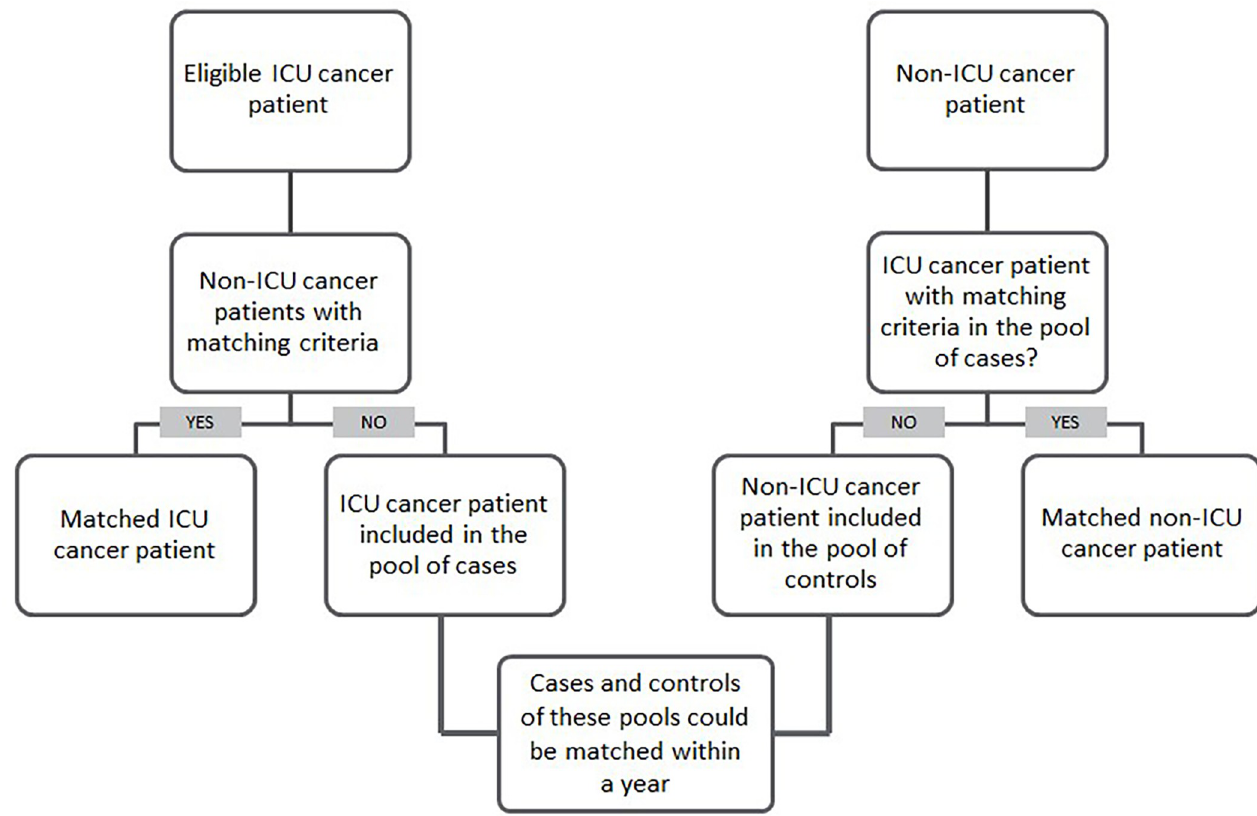
Fig 1. Method of prospective individual